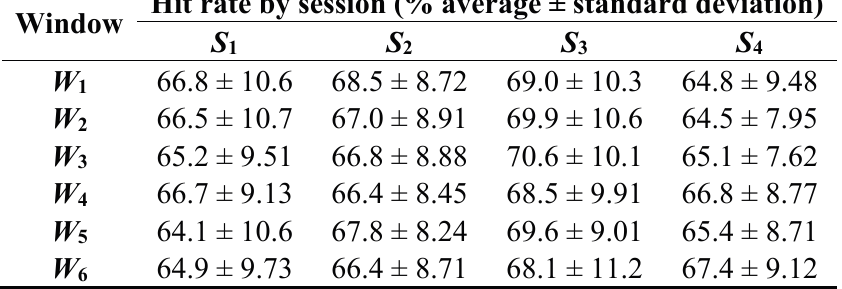
Table 2. Average hit rates with the LDA classifier using CSP channels and channels C3, C4, P3 and P4 to estimate W .